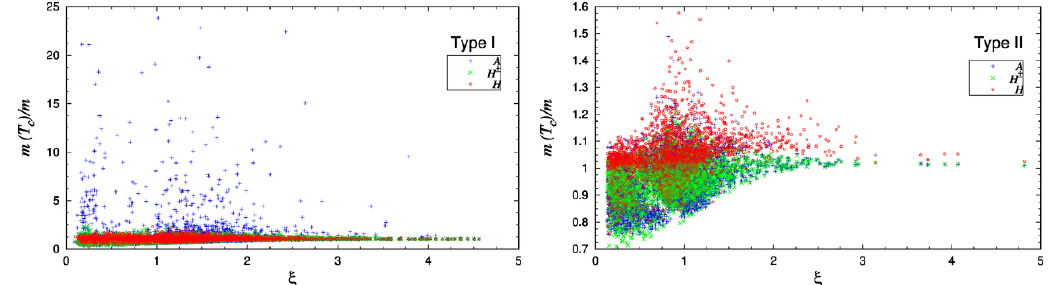
Figure 12 . The ratio of the thermal mass at the critical temperature to the zero-temperature mass for the three BSM states as a function of the PT strength (cid:24) . Only T c . 300 GeV points obeying